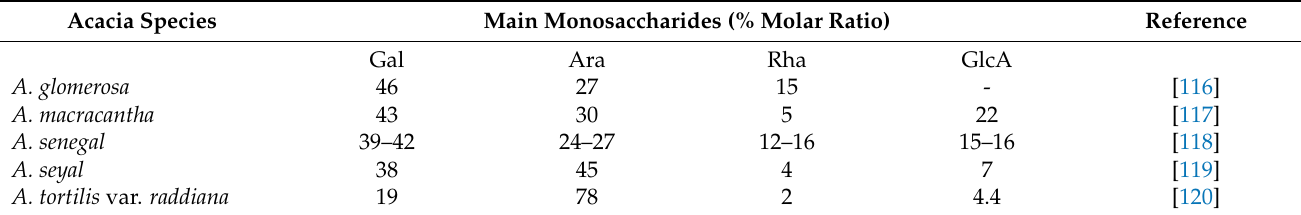
Table 3. Monosaccharide compositions of polysaccharides extracted from some Acacia species in arid lands. Acacia Species Main Monosaccharides (% Molar Ratio) Reference Gal